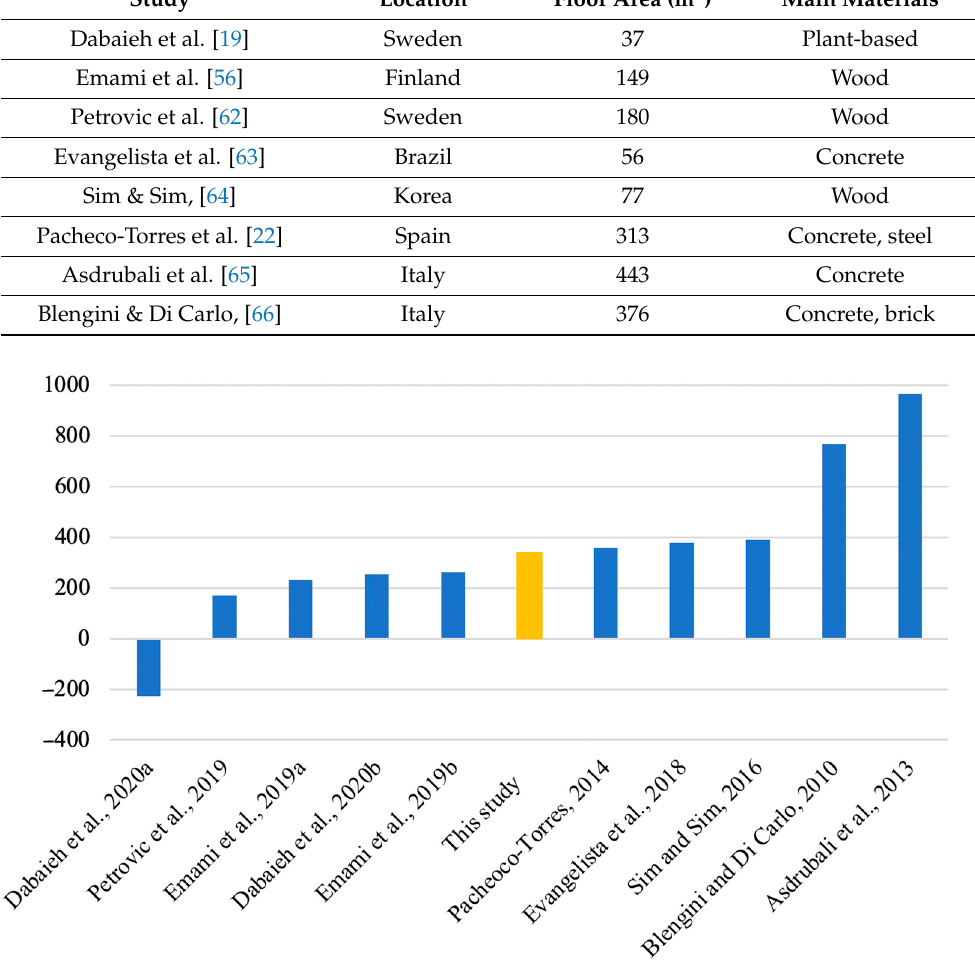
Figure 9. GWP reported for studies in Table 8 (kg CO 2 eq/m 2 ).